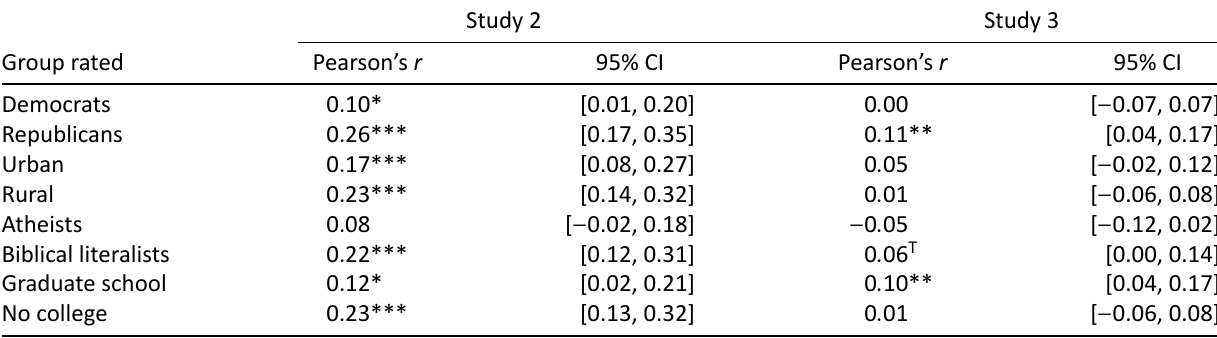
Table 5. Simple correlations between the average censorship score and the TPP scores.